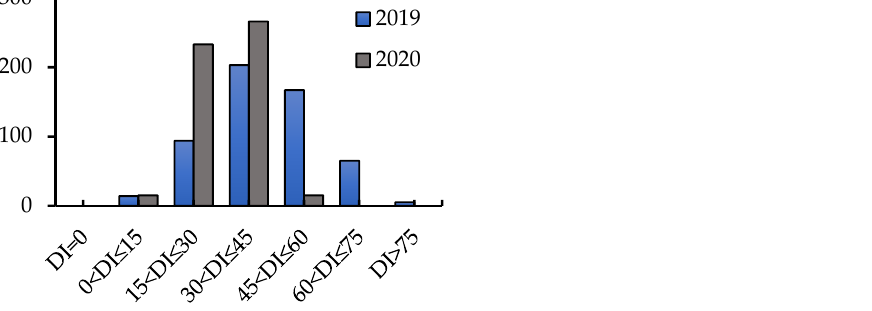
Figure 1. Phenotypic distribution for CR resistance in two years.